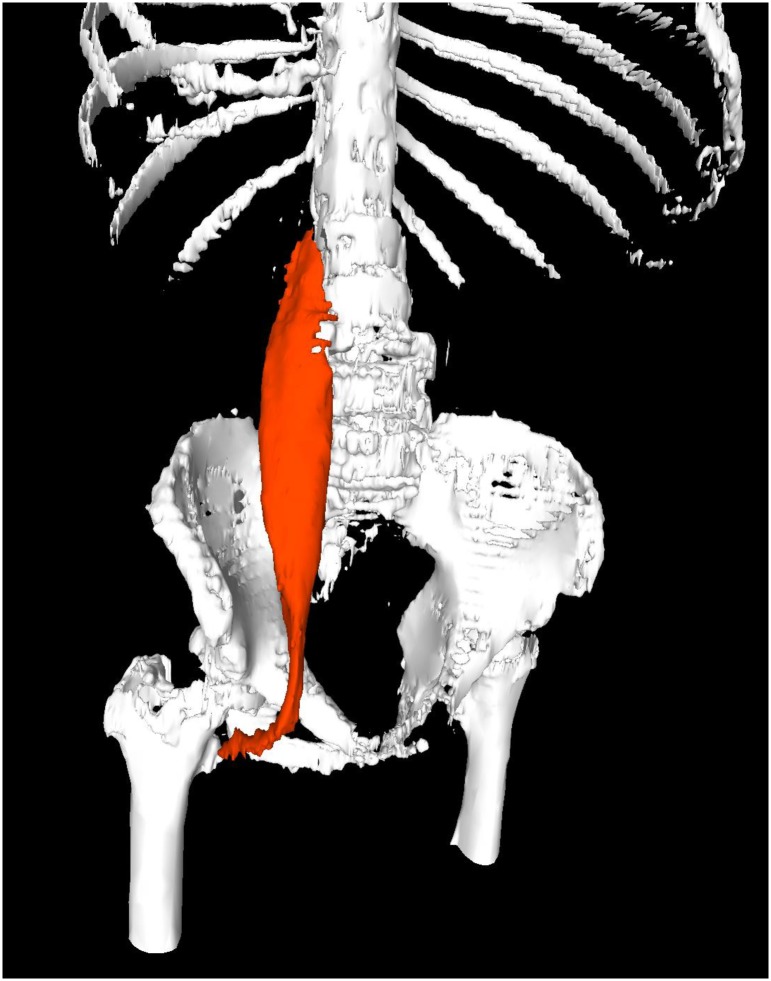
Psoas muscle volume.